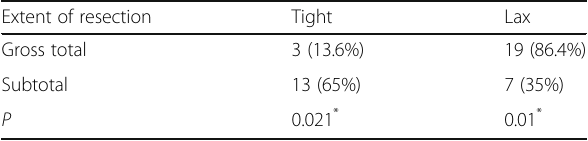
Table 2 Relation between degree of brain relaxation and the extent of resection Extent of resection